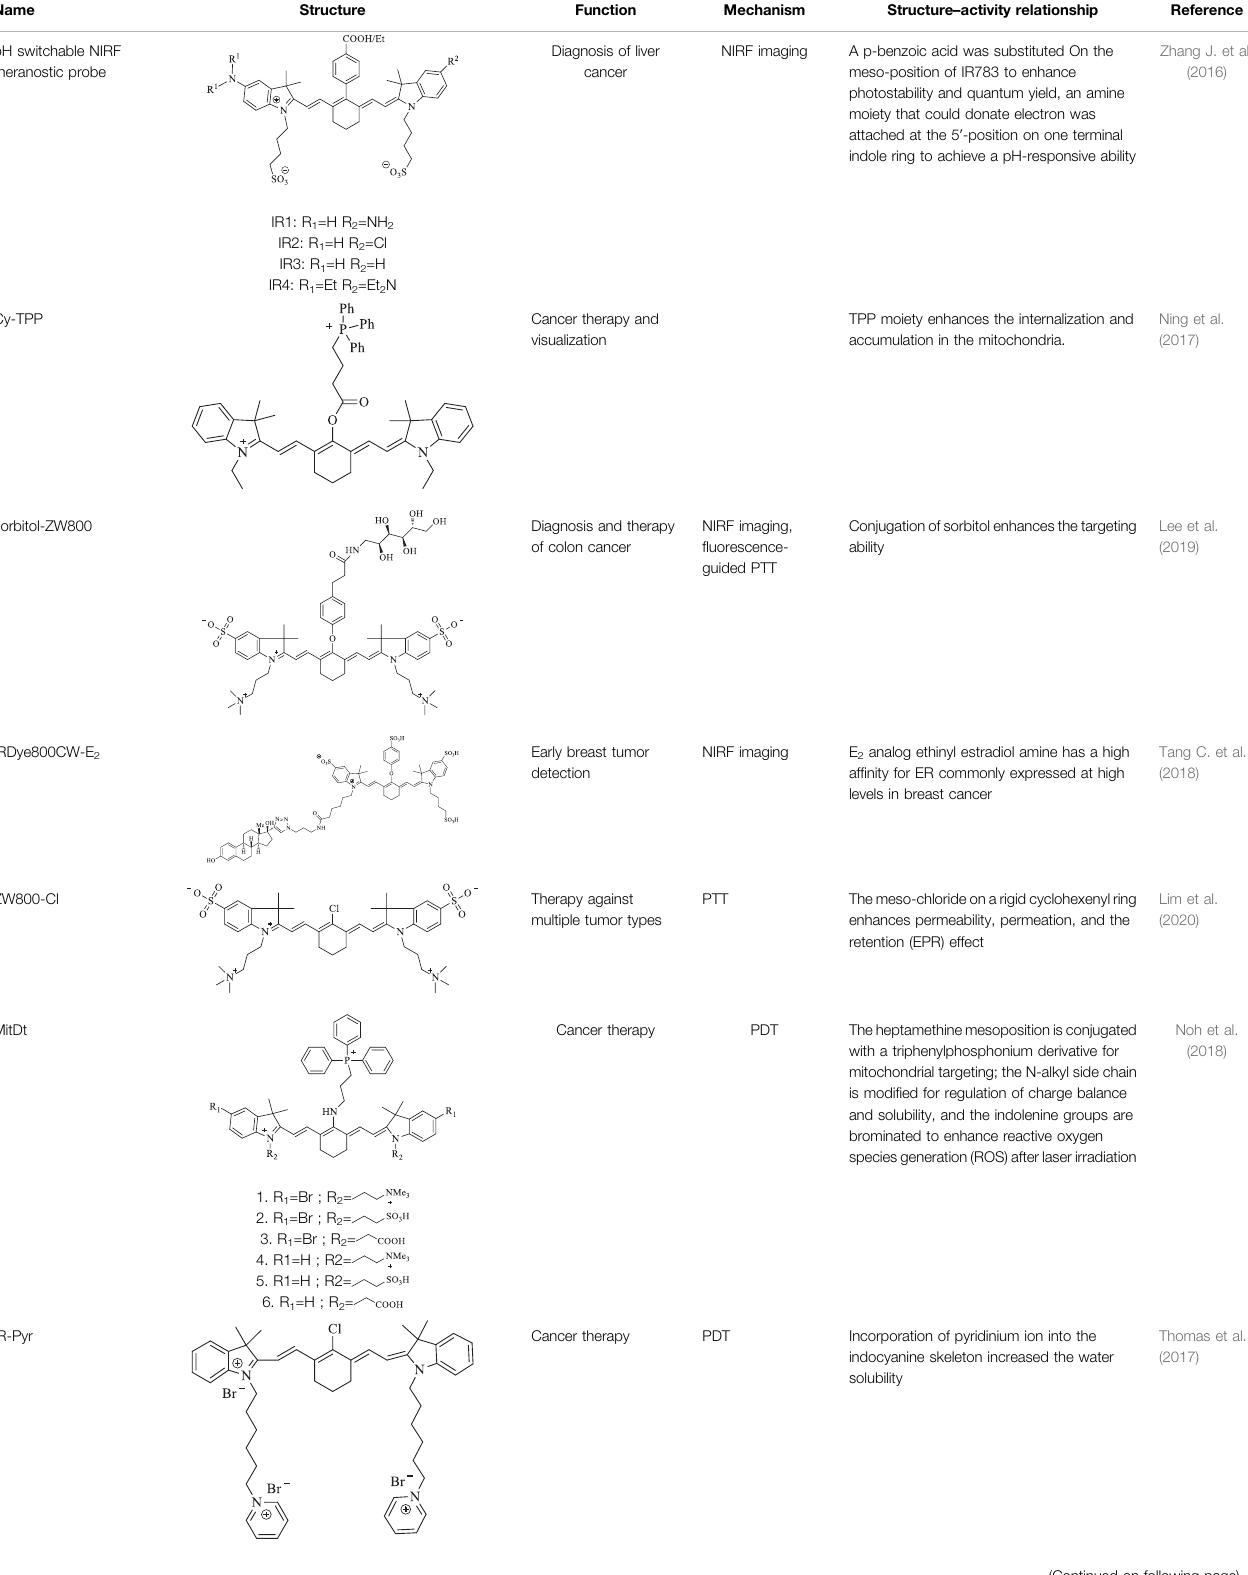
TABLE 1 | ( Continued ) Information on the structure and function of Cy7 and its